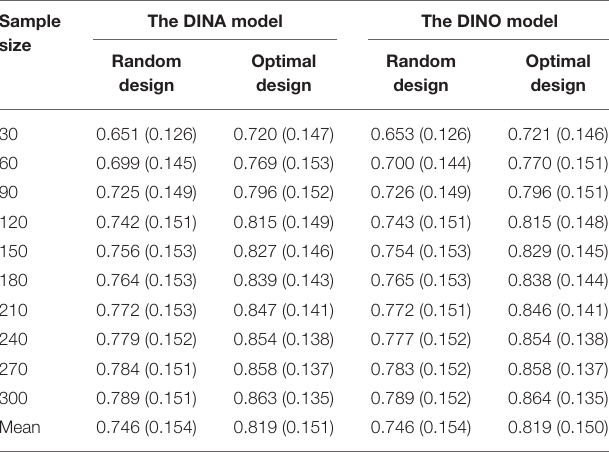
TABLE 1 | Mean and standard deviation (in brackets) of correct recovery rate of q-entries for two models and two